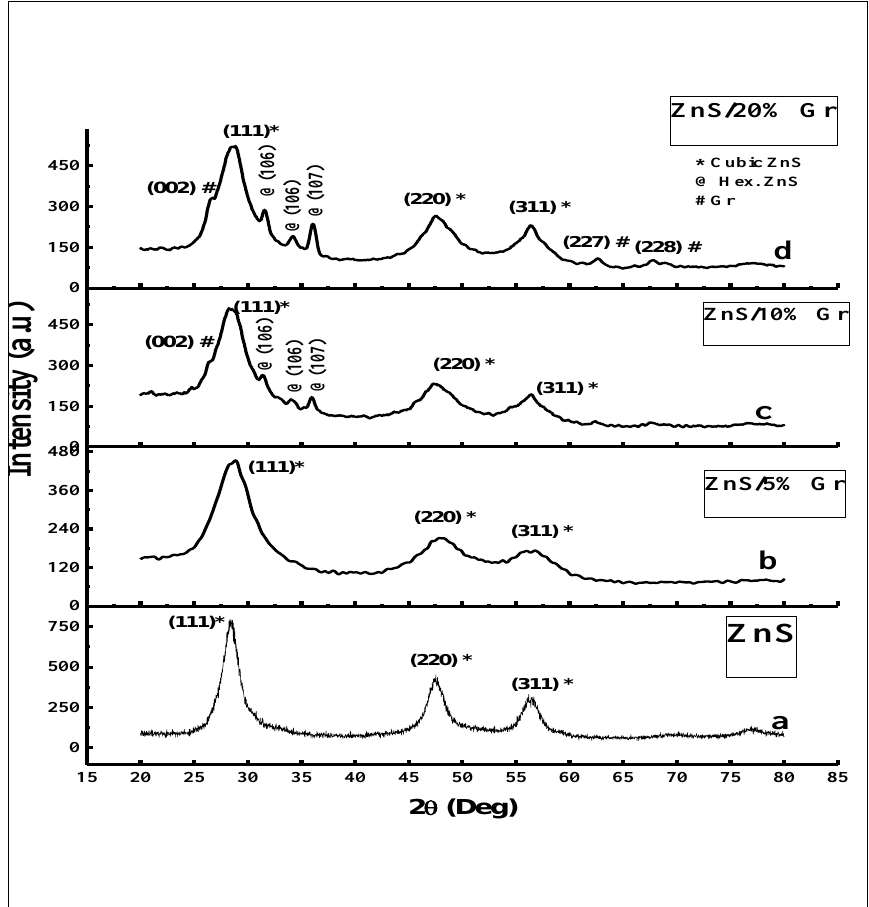
Fig.1: XRD patterns for ZnS-Gr at different volume ratios of